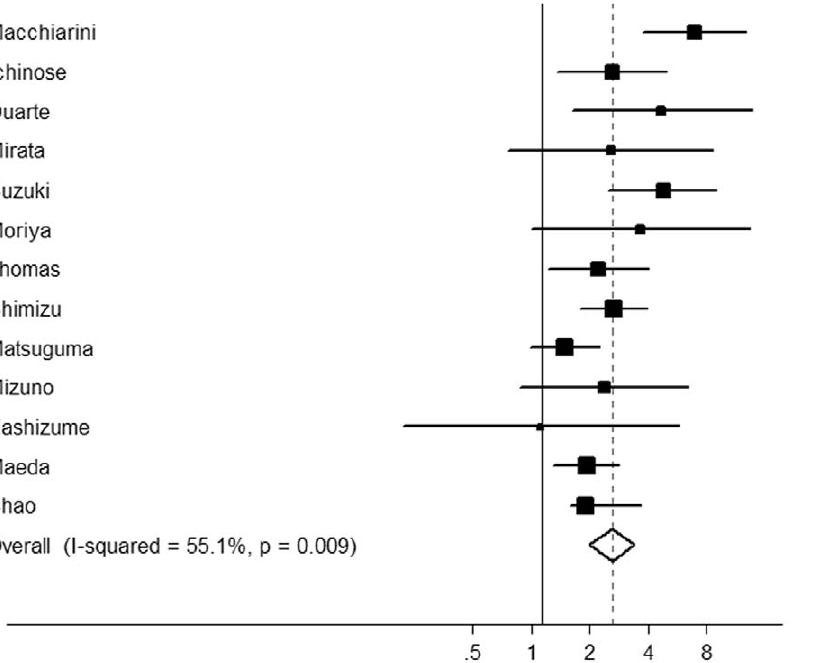
Figure 3. Forest plot showing the combined relative hazard ratio for overall survival of stage I patients by multivariate analysis.